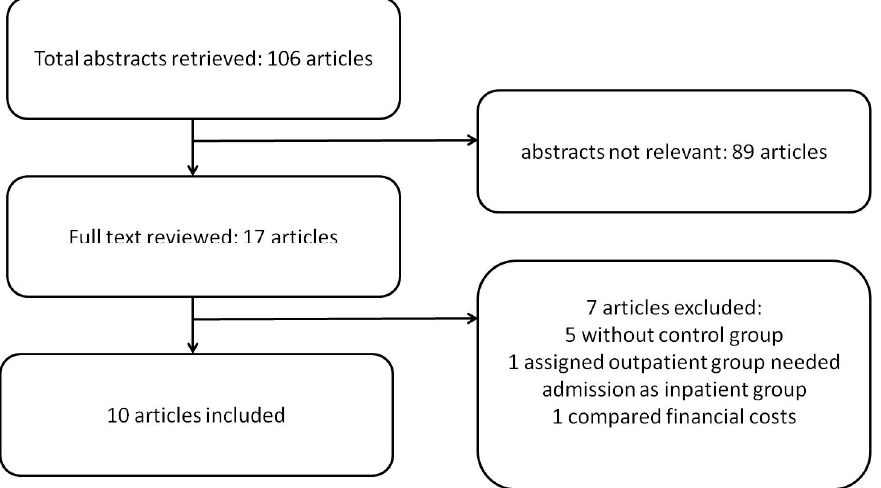
Figure 1. Study flow diagram.